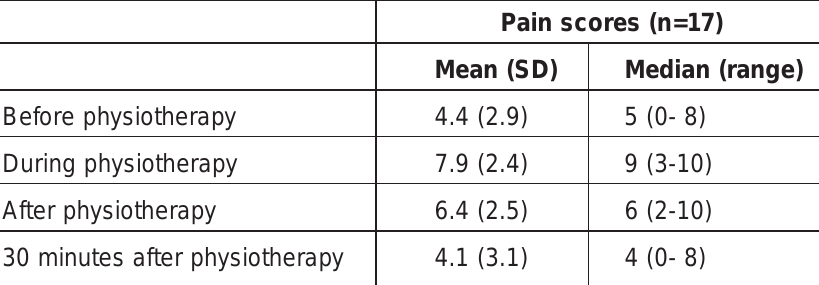
Table 1: Pain scores (mean and median scores) as reported by subjects before, during and after physiotherapy